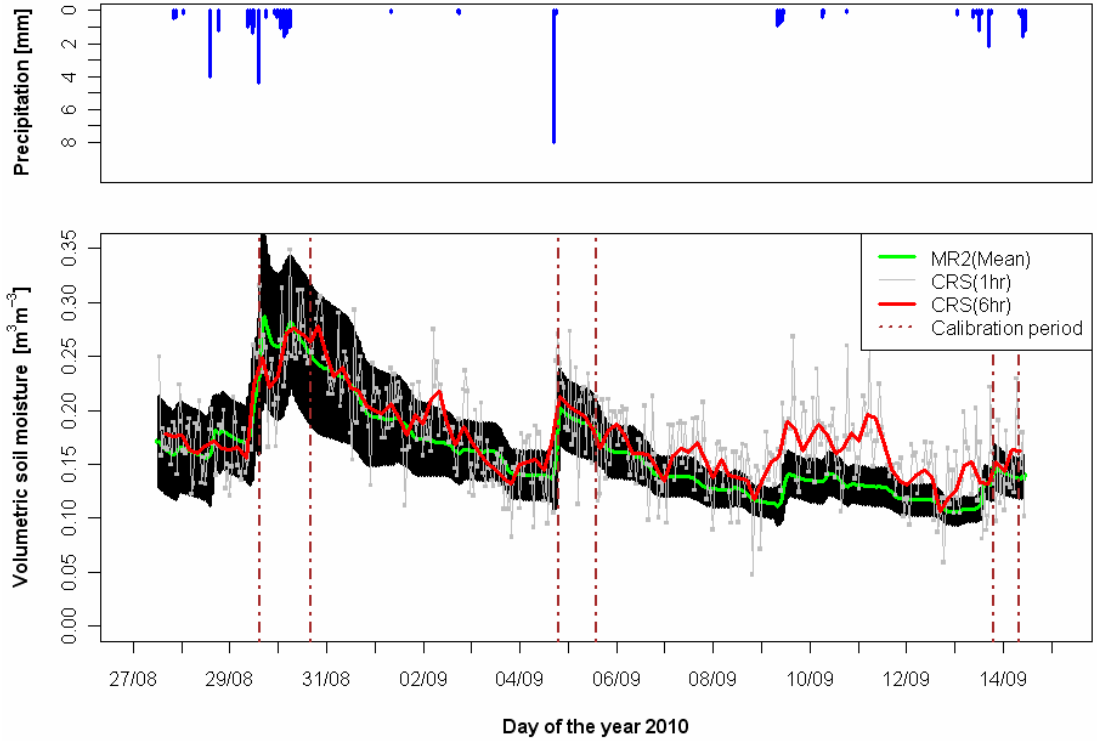
Fig. 7. Soil moisture inferred by the GANS method plotted for a period of cropped field condition. Upper graph: hourly precipitation time series data measured in ATB weather station. Lower graph: soil moisture time series data measured by MR2 probes (spatial mean hourly value in green and one standard deviation in black band) and CRS-1000 (1-h estimations and 6-h moving average in gray and red colors, respectively). The three periods used for calibration of CRS-1000 are shown between vertical dashed lines.